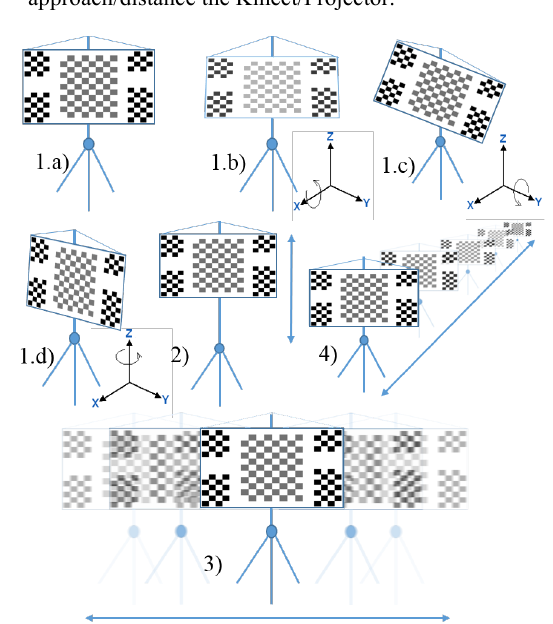
Figure 9 - Different positions and angulations used during the calibration.